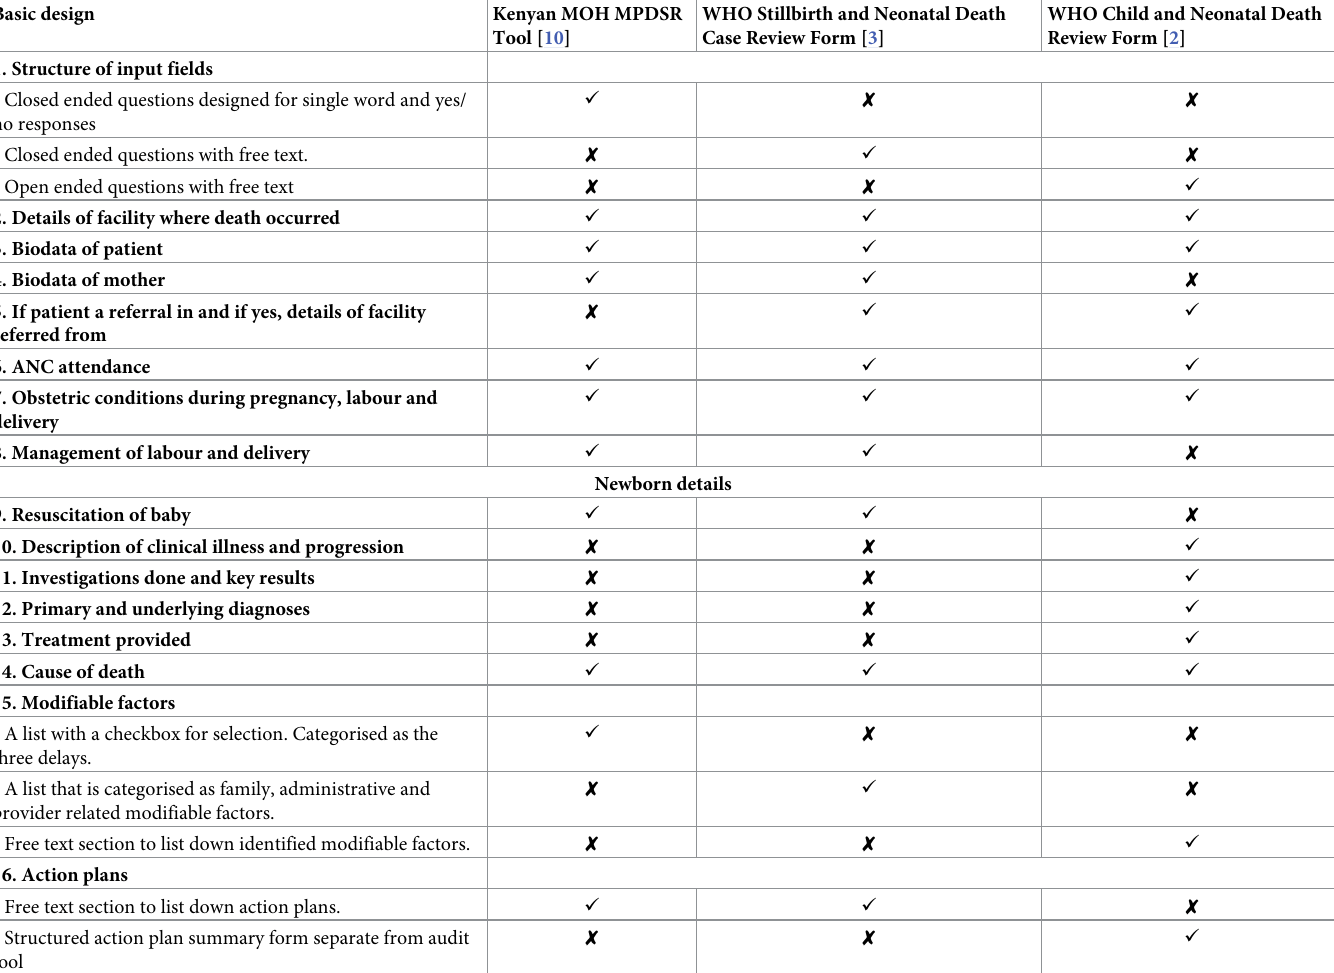
Table 1. Summary of structure and content of available perinatal, neonatal and child clinical audit tools. Basic